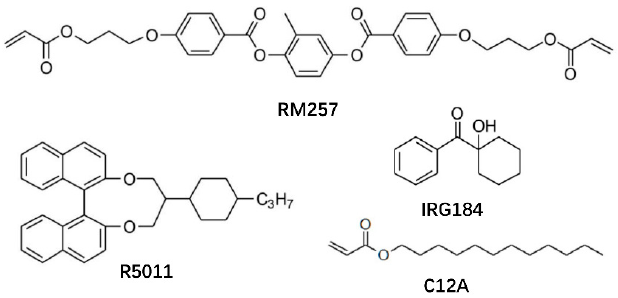
Figure 1. Chemical structures of chiral dopant, monomers, and photoinitiator.